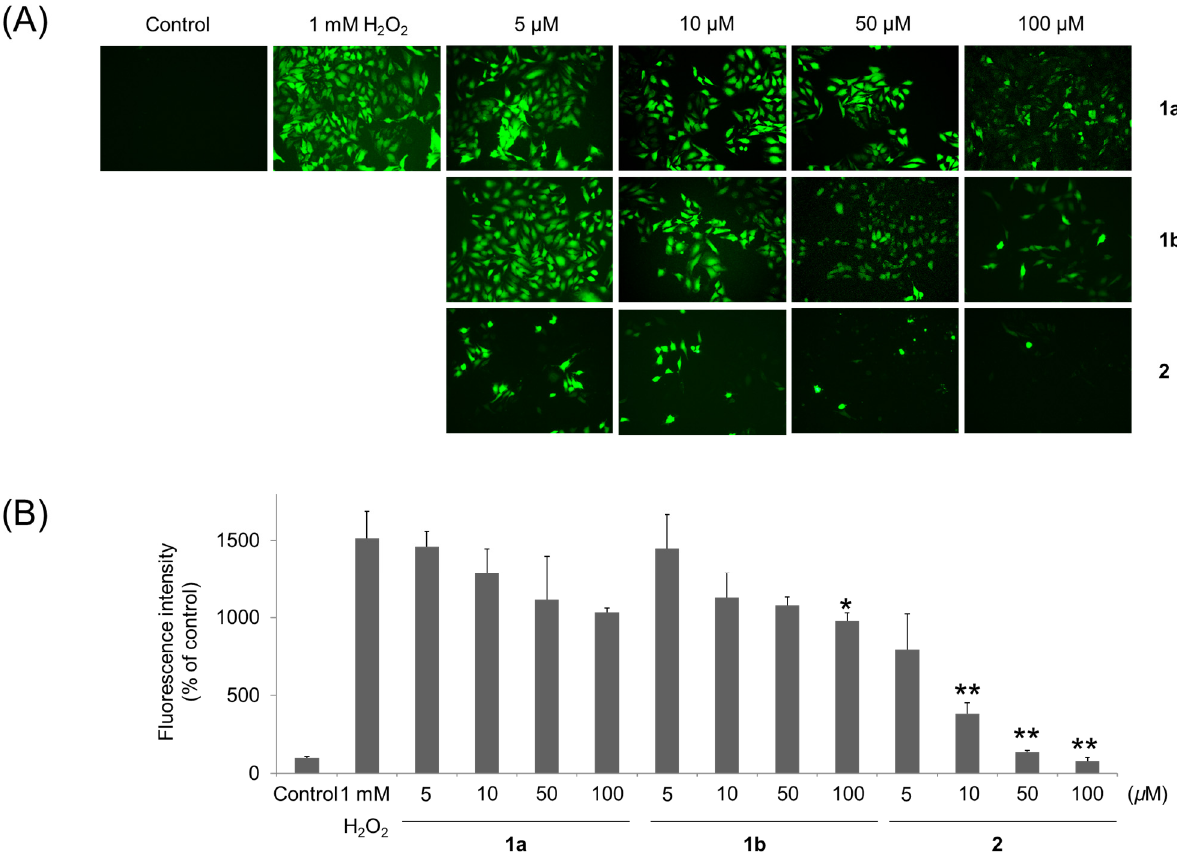
Figure 5. ( A ) Reactive oxygen species (ROS) scavenging activities as revealed by images of human umbilical vein/vascular endothelium cells (HUVECs) with 2 (cid:48) ,7 (cid:48) -dichlorofluorescin diacetate (DCFDA) treated with 5–100 µ M of compound 1a , 1b , or 2 . ( B ) Scavenging percentages of the tested compounds. * p < 0.05, ** p <